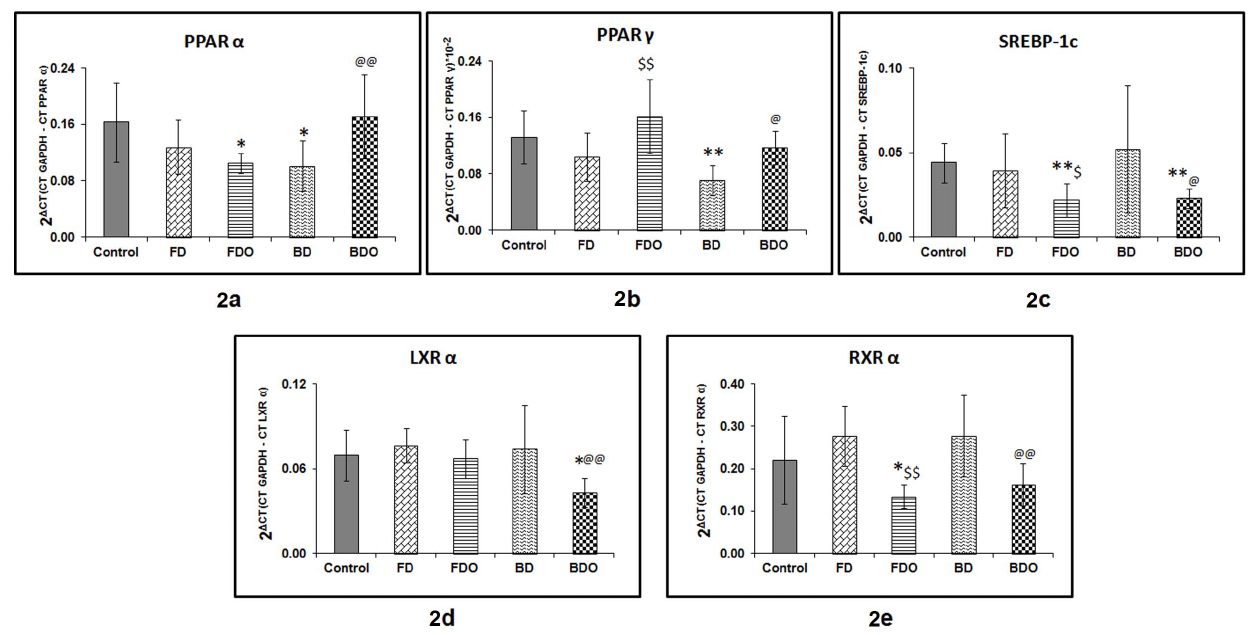
Figure 2. Pup liver gene expression in different groups. Figure 2a- Pup liver PPAR a expression in different groups. Figure 2b- Pup liver PPAR c expression in different groups. Figure 2c- Pup liver SREBP-1c expression in different groups. Figure 2d- Pup liver LXR a expression in different groups. Figure 2e- Pup liver RXR a expression in different groups. Gene expression was carried out in pup liver using real time PCR. Data in each group is on 4 males and 4 females. The treatment groups were compared with the control group by ANOVA and the post-hoc least significant difference test. Data is presented as the mean 6 SD of 2 D CT where D CT is CT (GAPDH) – CT (target gene). *p , 0.05 as compared to control; **p , 0.01 as compared to control; $ p , 0.05 as compared to FD group; $$ p , 0.01 as compared to FD group; @ p , 0.05 as compared to BD group; @@ p , 0.01 as compared to BD group. Control – Normal folic acid, normal vitamin B 12 ; FD– folic acid deficient; BD – vitamin B 12 deficient; FDO– folic acid deficient and omega-3 fatty acid supplementation; BDO– vitamin B 12 deficient and omega-3 fatty acid